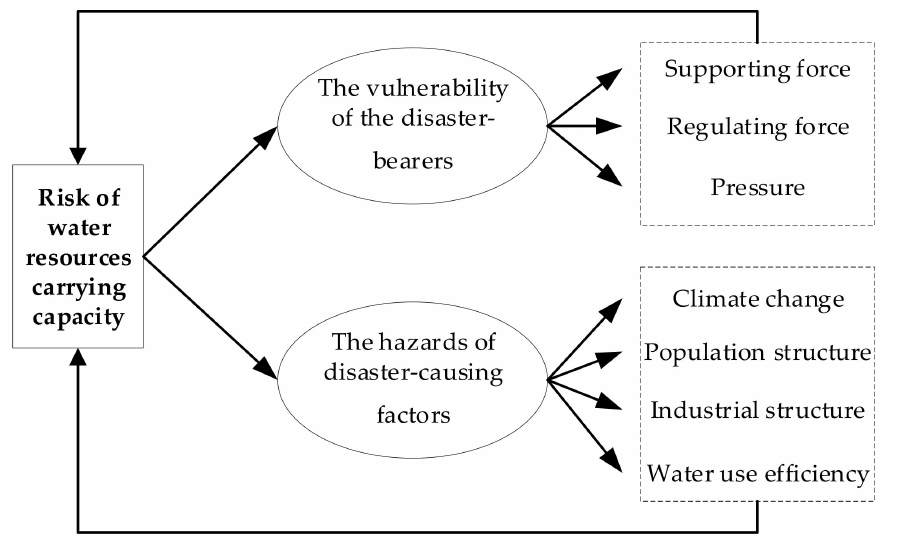
Figure 1. Risk of water resources carrying capacity